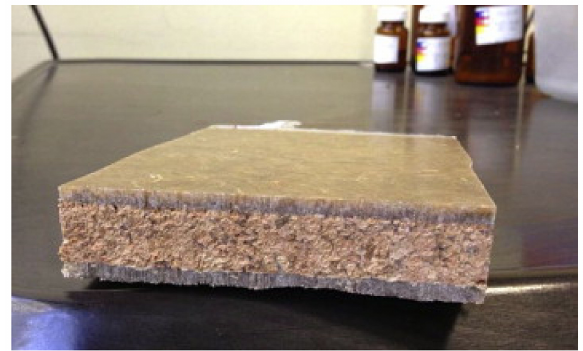
Figure 26. Eco-sandwich with core in granulated cork and skins in hemp / bio-resin. Reprinted from [101], © 2020 with permission from Elsevier.